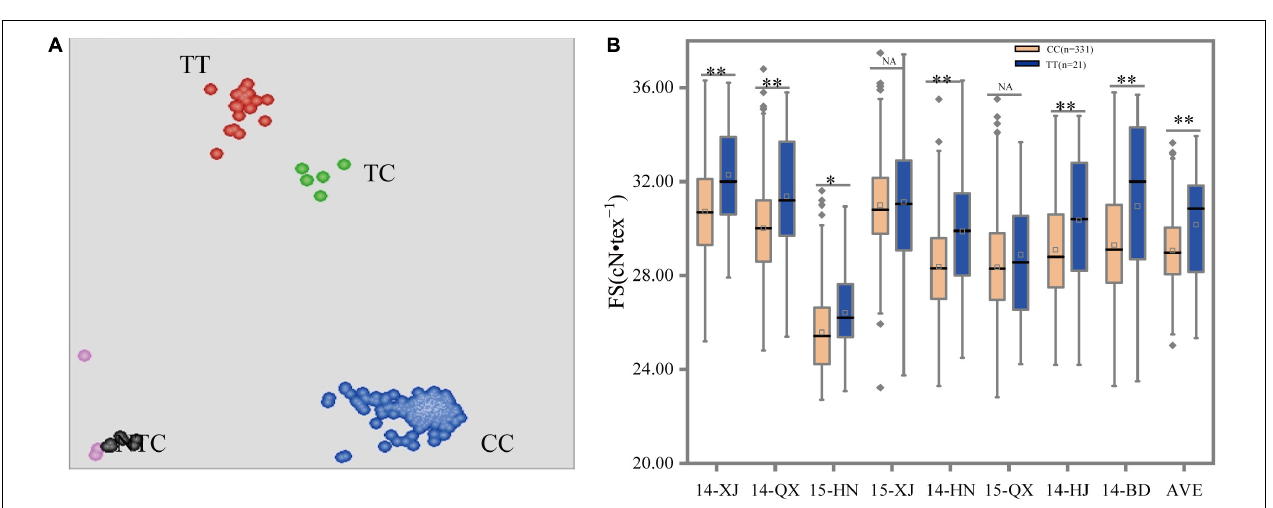
Frontiers in Plant Science |